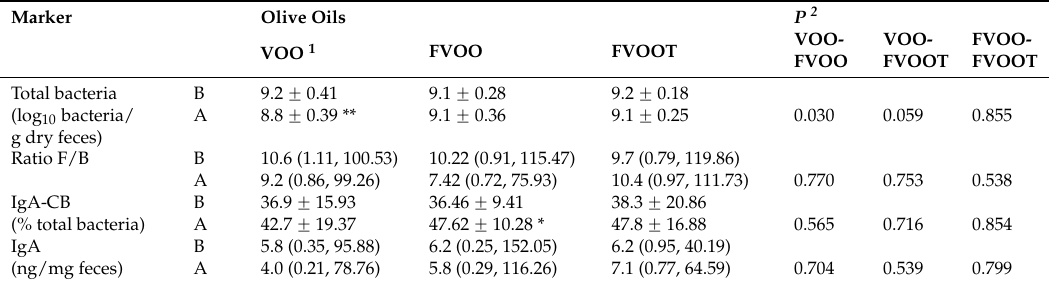
Table 4. Markers of intestinal immunity before (B) and after (A) each olive oil intervention 1 . Marker Olive Oils P